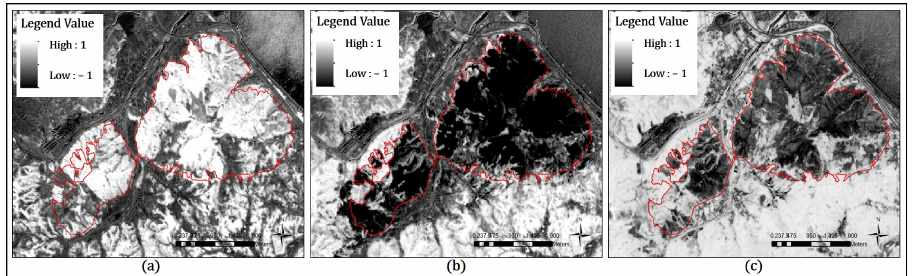
Figure 4. Normalized Burn Ratio (NBR) images: ( a ) pre-fire, ( b ) right after the fire, and ( c ) four months later.